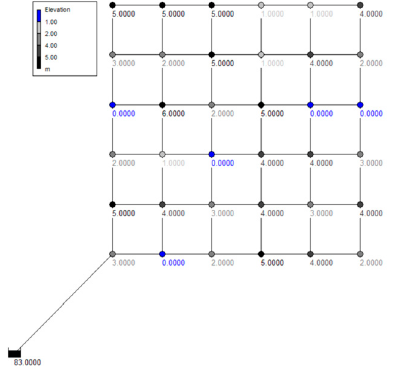
Figure 7. Set of nodal elevations randomly generated in Case 3.